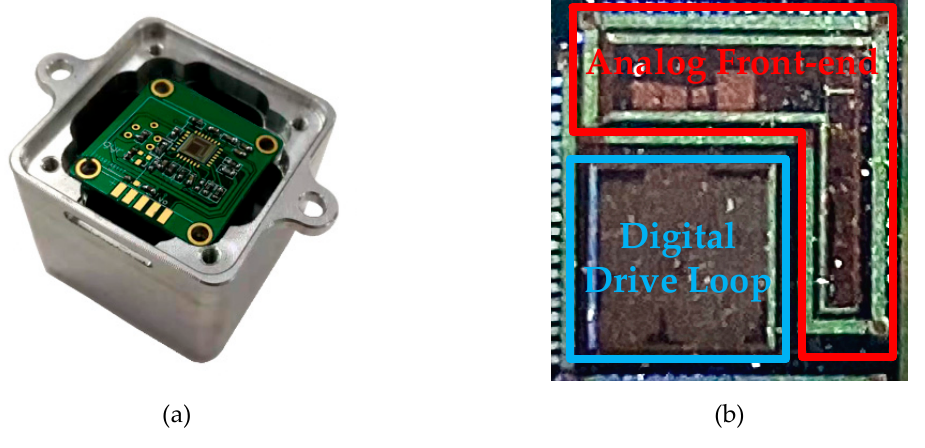
Figure 11. ( a ) Prototype test package, ( b ) layout of the overall chip.